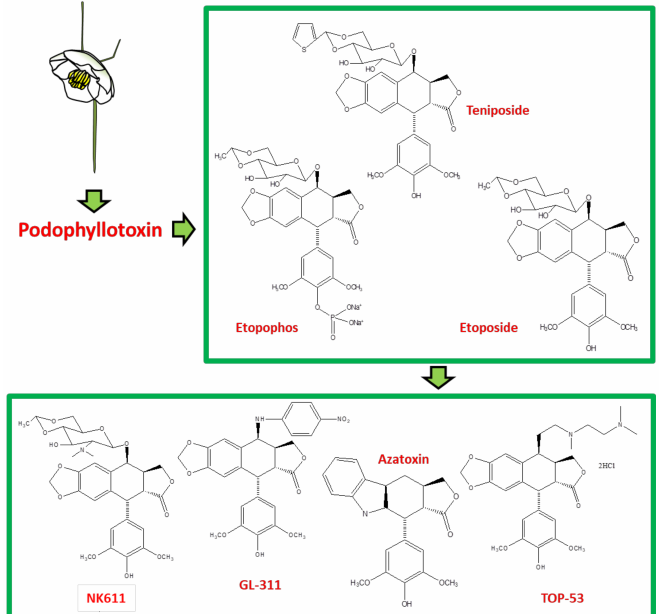
Figure 1. The sequential discovery of podophyllotoxin-group of drugs. FDA approved anticancer drugs etoposide, teniposide and etopophos were derived from the parent compound podophyllo- toxin, which was originally extracted from mayapple plant as a curative for various diseases. As the side-effects for podophyllotoxin and its primary derivatives became evident, less toxic derivatives such as TOP-53, NK611, GL-331, azatoxin and various others were designed and